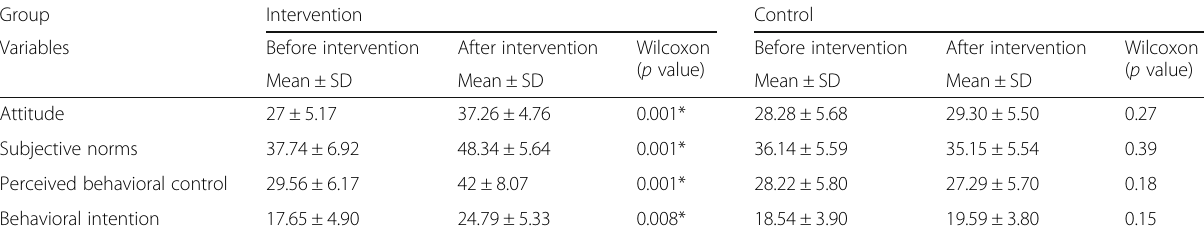
Table 4 The mean scores of the TPB constructs in the intervention and control groups before and after the educational intervention in Khoy and Urmia, Iran, 2016 Group Intervention Control Variables Before intervention After